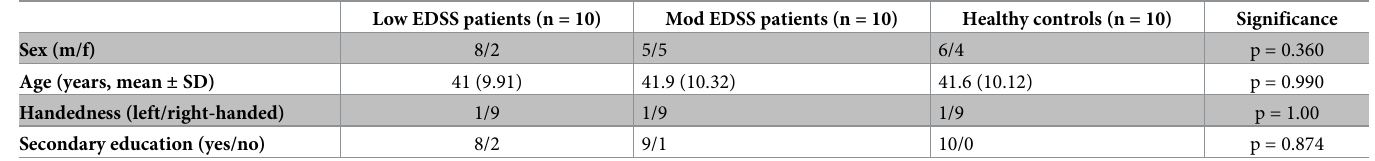
Table 1. Demographic data of experimental